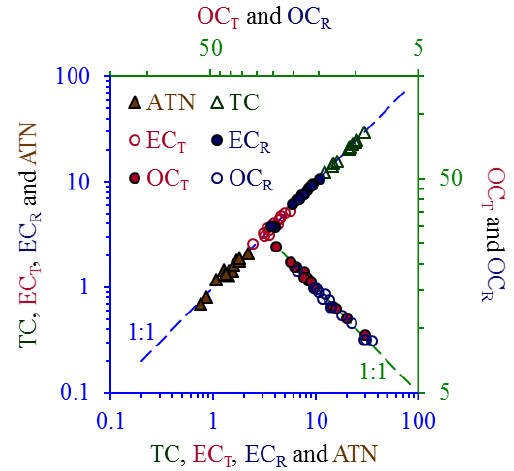
Figure 1. Comparison of the carbon (i.e., TC, OC and EC) and opti- cal (i.e., ATN) measurements performed by duplicate analysis. TC, OC and EC are presented in µgCcm − 2 . The subscripts “R” and “T” indicate reflectance- and transmittance-based charring correction,